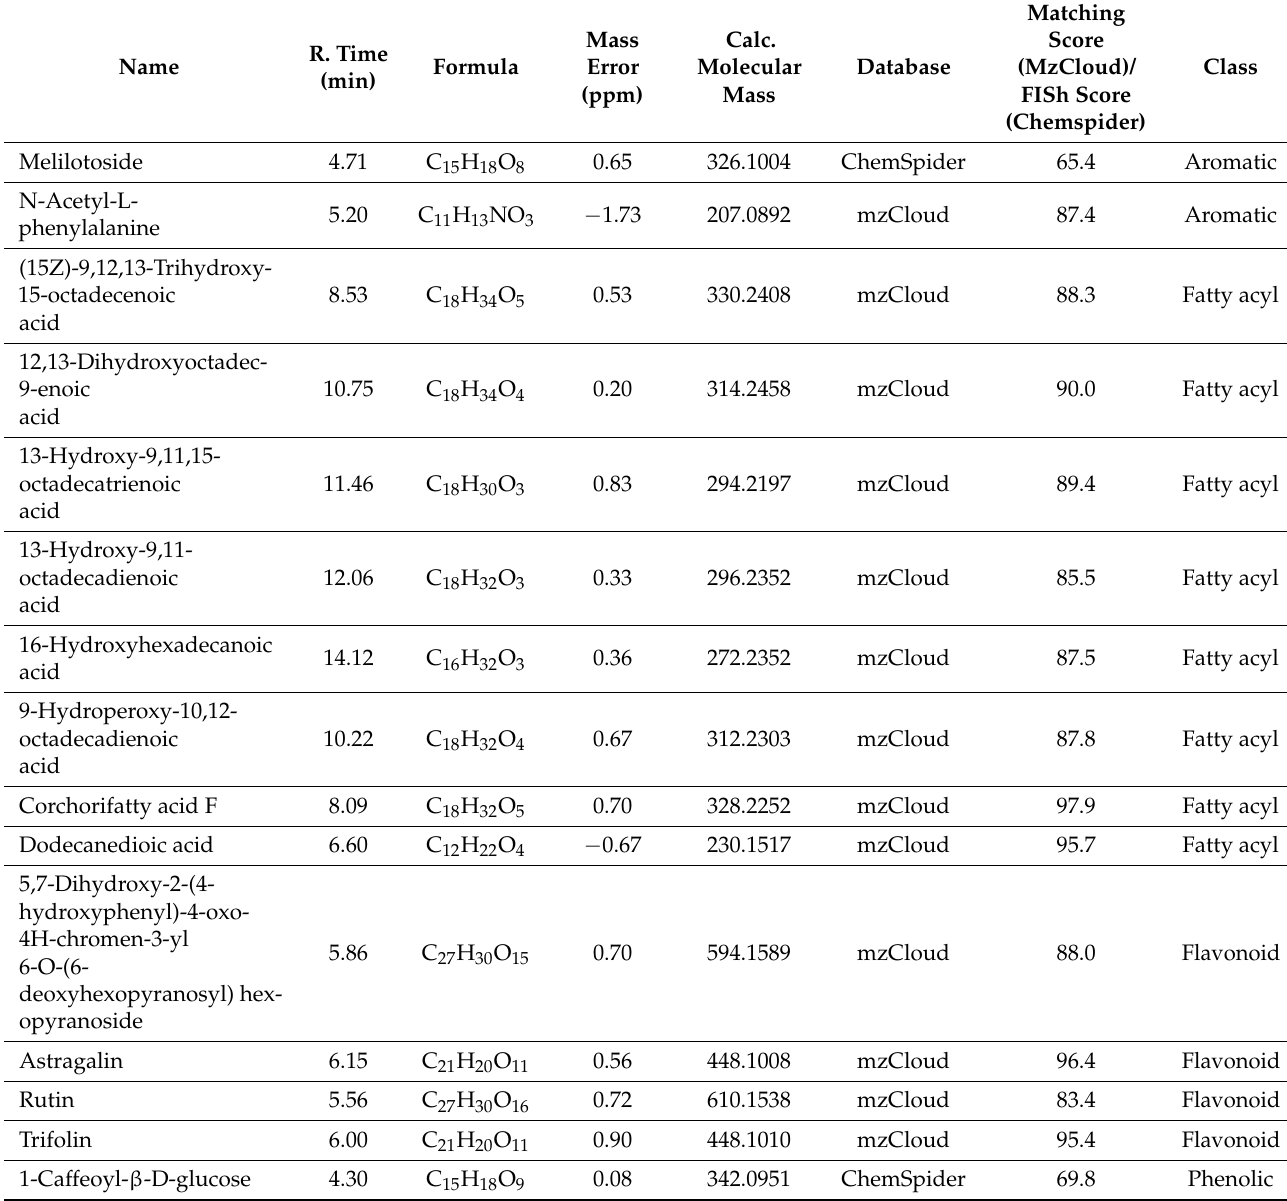
Table 2. Compounds identified in LM aqueous extract by negative mode of